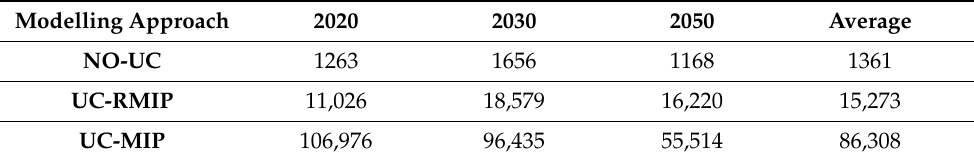
Table 5. Influence of year and UC modelling approach on the sum of computational time of all day-ahead (DA) optimisations